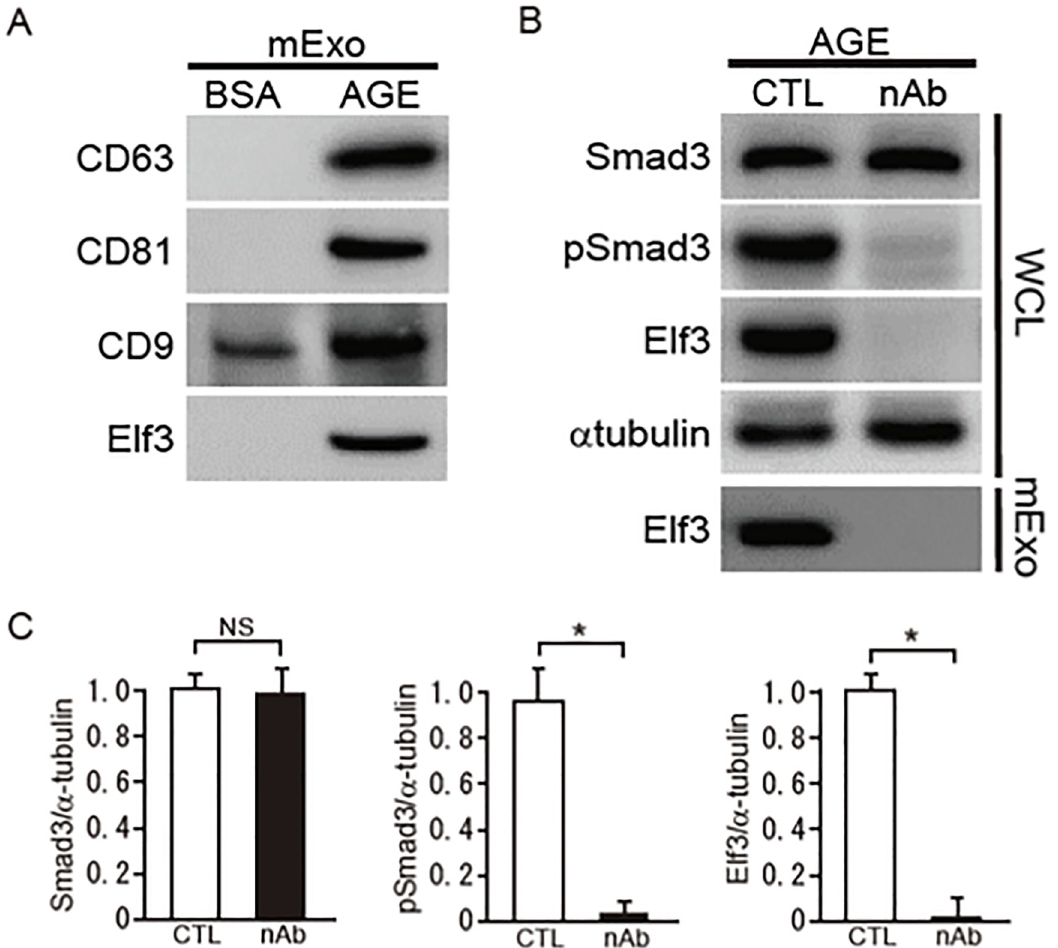
Fig 4. Elf3 protein in exosome in media from cultured podocytes exposured to AGE. (A) Expression of Elf3 protein in mouse podocytes cultured in exosome-free medium under exposure to BSA or AGE (5 μ g/ml) for 48 h was monitored by western blotting. Western blot analysis for CD63, CD81, and CD9 as exosome markers for exosomes obtained from conditioned media (mExo) from cultured podocytes. (B) Podocytes were treated with neutralizing antibodies for BMP4 (nAb: 10 μ g/ml) or control normal IgG (CTL) for 24 h after a 24-h exposure to AGE (5 μ g/ml). Equal amounts of whole cell lysates (WCL) or exosomal proteins obtained from conditioned media (mExo) were subjected to western blotting. One of three independent experiments is shown. α -tubulin was used as a loading control. (C) Optical densitometry of these proteins in western blot was shown. The values are expressed as the mean ± S.E. (NS, not significant, � , p < 0.05, t